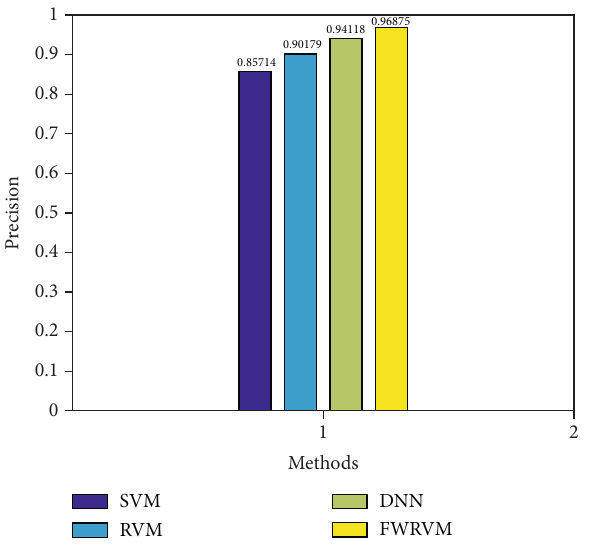
Figure 4: Precision comparison. Figure 5: Recall comparison.